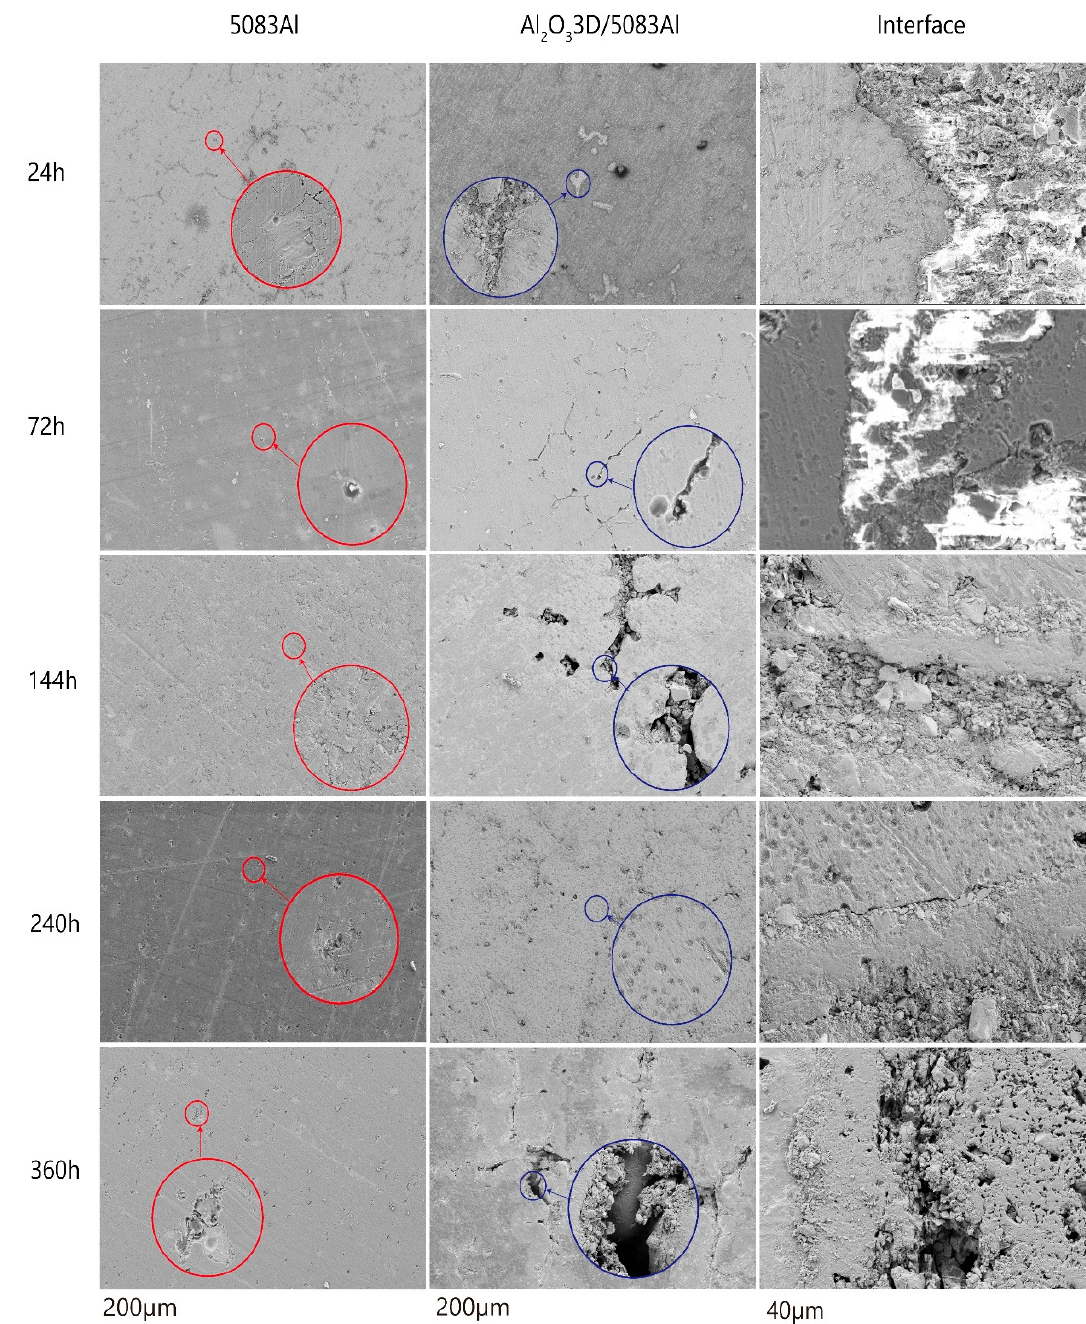
Figure 7. Corrosion morphology of Al 2 O 3 3D/5083Al and 5083Al under different times after NSS (neutral salt spray) corrosion.